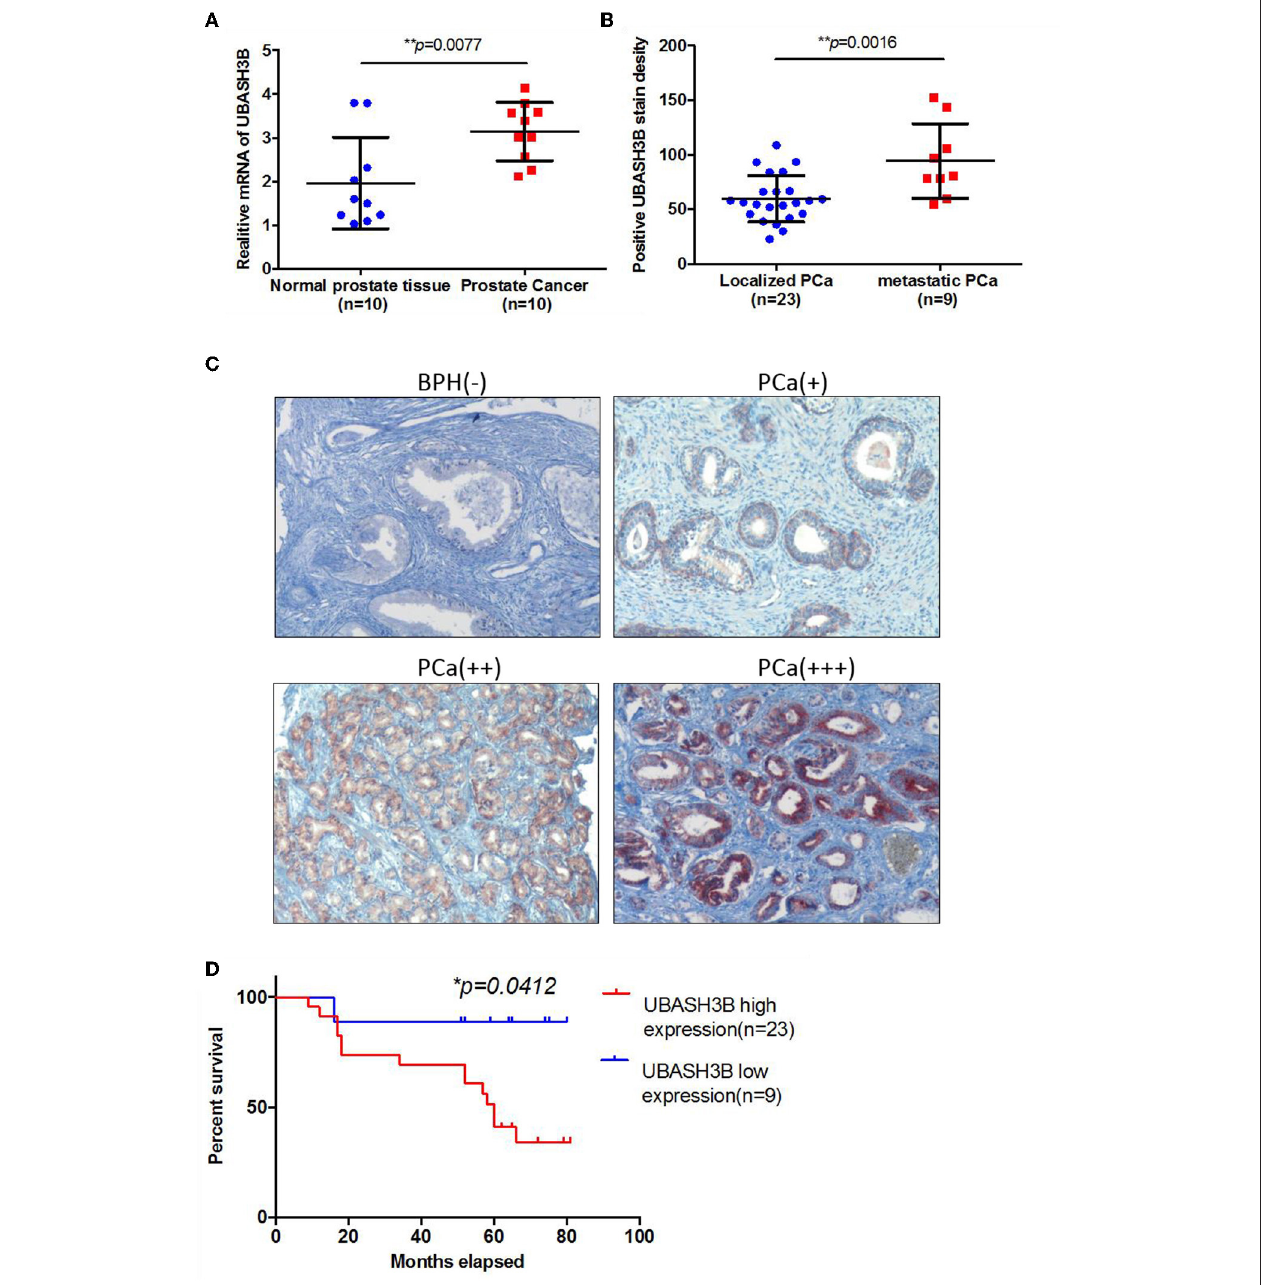
FIGURE 1 | (A) The mRNA expression of UBASH3B is significantly upregulated in prostate cancer tissue as compared with normal prostate tissue ( p = 0.0077). (B) The expression of UBASH3B is significantly associated with tumor metastatic status of prostate cancer ( p = 0.0016). (C) Differential expression level of UBASH3B in benign prostate hyperplasia (BPH) tissue and prostate cancer (PCa) tissue. Weak expression ( + ); Moderate expression ( ++ ); Strong expression ( + + + ). (D) Data indicate that the expression levels of UBASH3B are associated with poor prognostic survival in prostate cancer patients ( p = 0.0412).